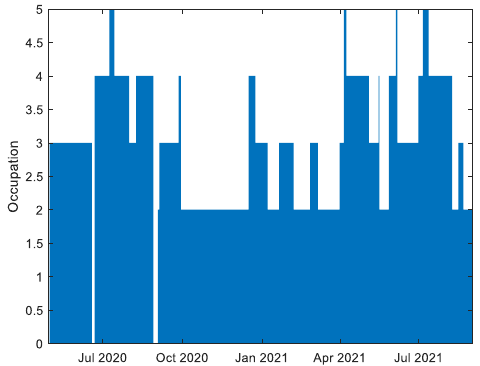
Figure 7. Figure 7. Occupation.